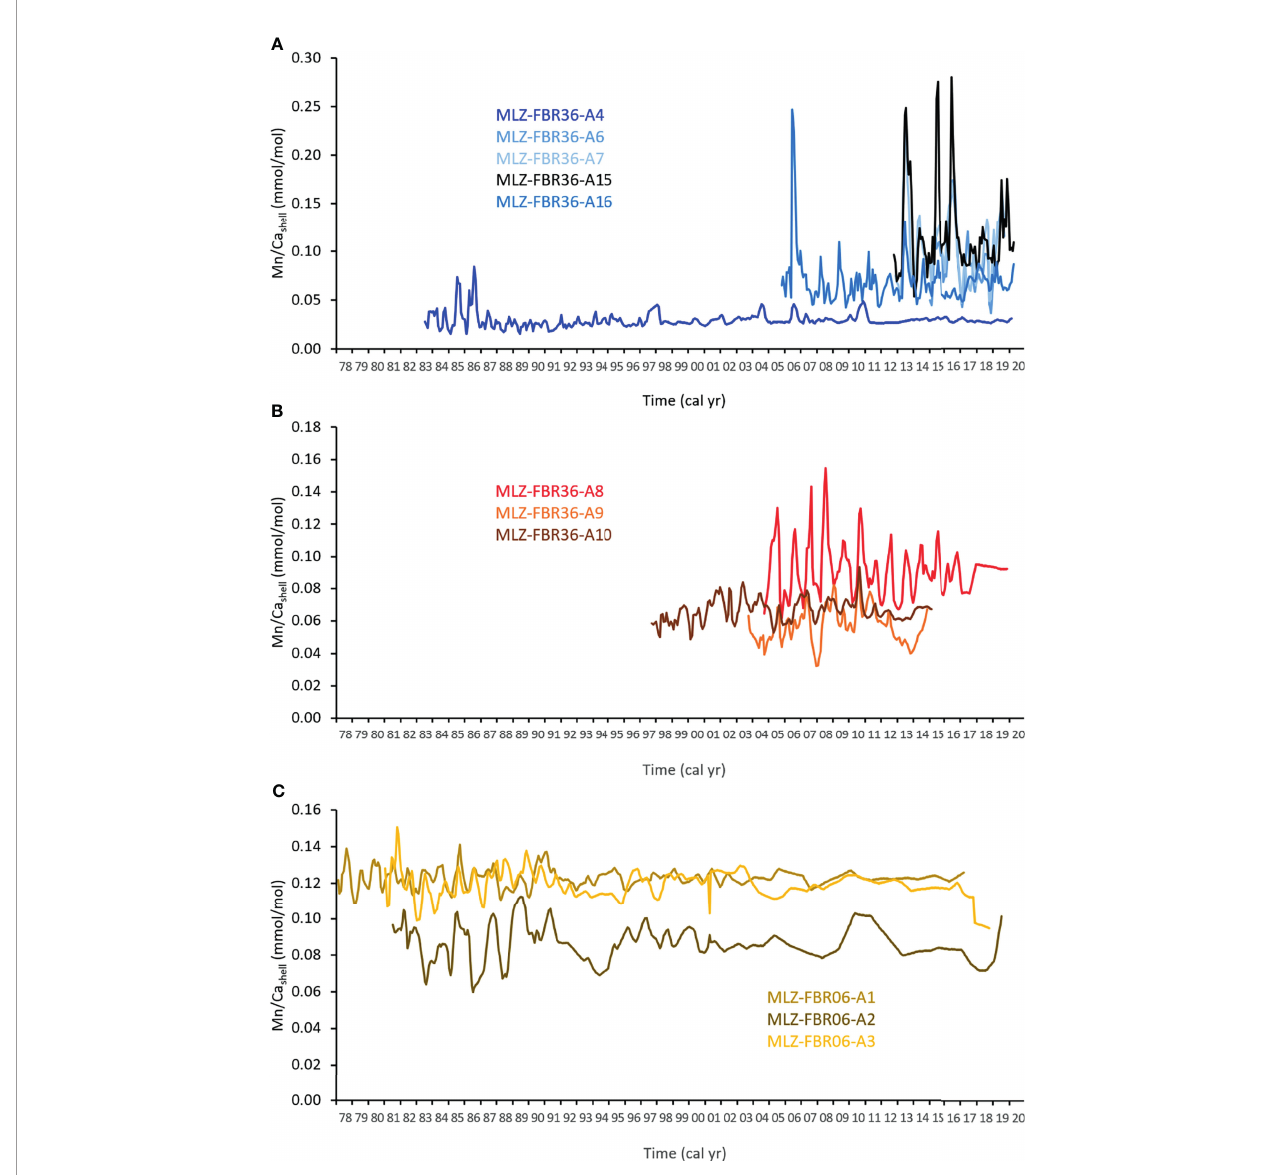
FIGURE 7 | After removal of ontogenetic age-related trends (compare Figure 5 ), Mn/Ca shell chronologies (monthly resolution) reveal distinct differences between conspeci fi c specimens during the same calendar year. (A) A. islandica ; (B) A. elliptica ; (C) A. borealis